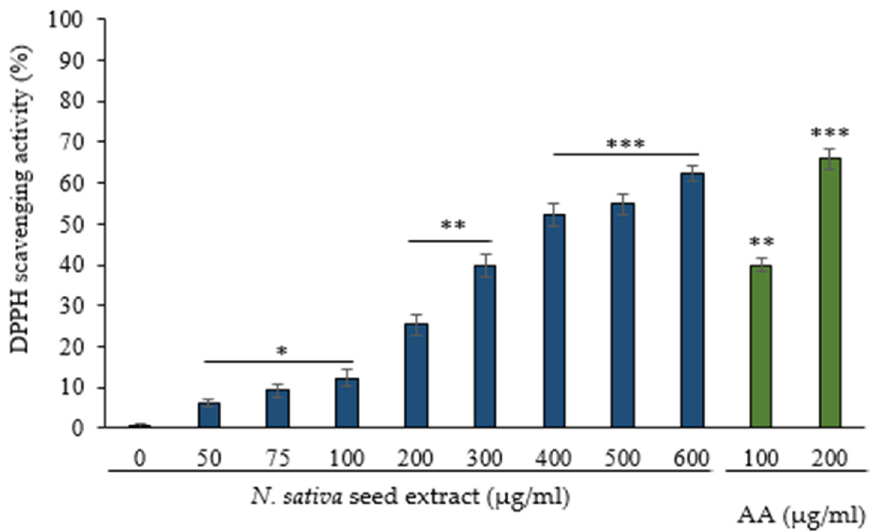
Figure 2. DPPH scavenging activity (%) of N. sativa seed methanolic extract. Ascorbic acid (AA) was used as the positive control. The results are presented as means ± SEM ( n = 3. The statistical analysis was performed by using ANOVA (* p ≤ 0.05, ** p ≤ 0.01, *** p ≤ 0.001).